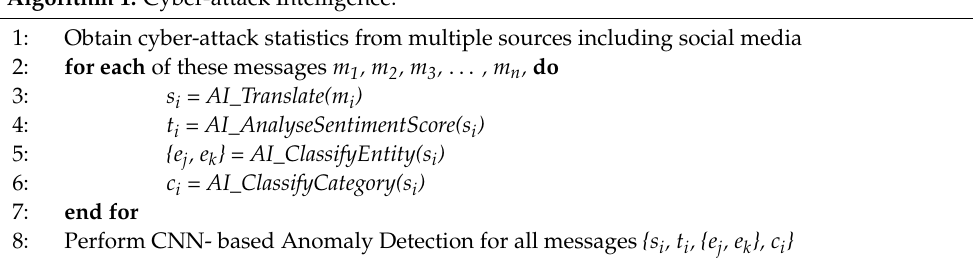
Algorithm 1. Cyber-attack Algorithm 1 Cyber ‐ attack Intelligence